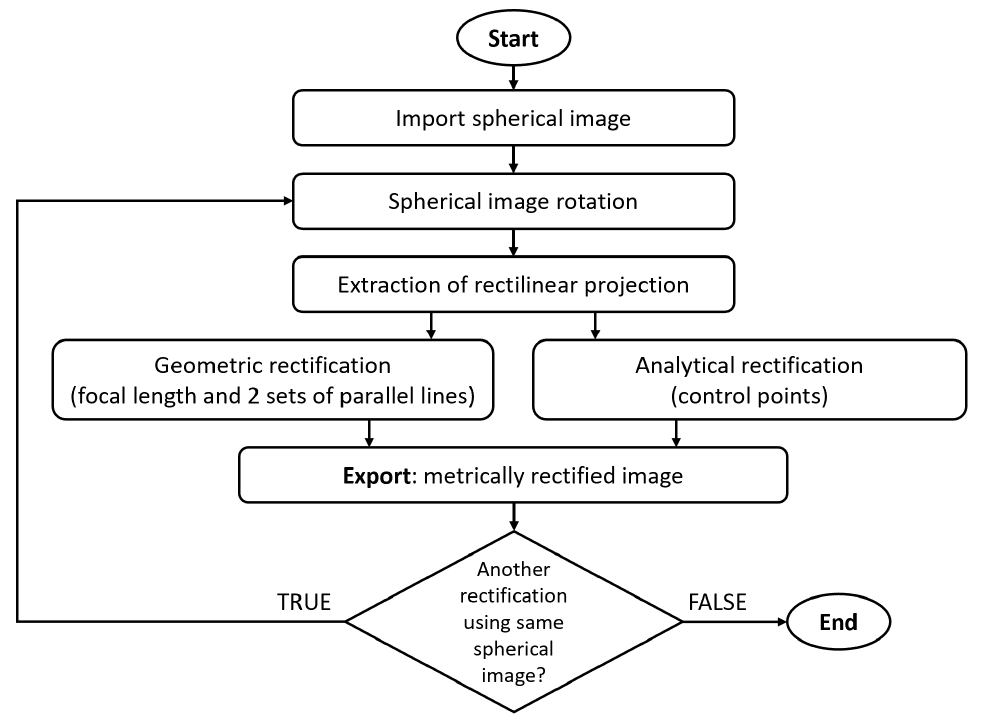
Figure 1. The developed workflow for metric rectification of several images from a single spherical